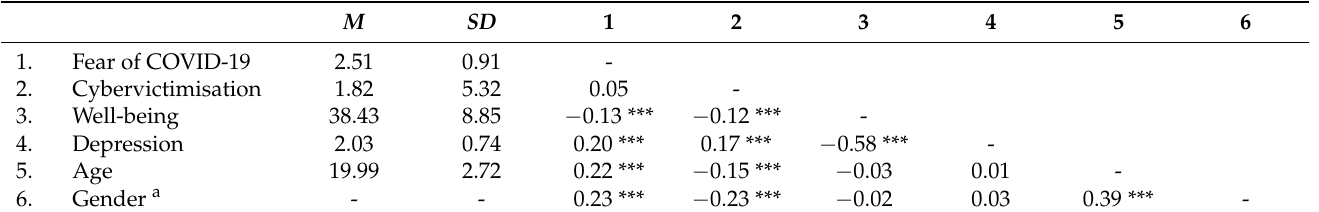
Table 1. Mean, standard deviation, and Pearson bivariate correlations among study variables ( N = 580).